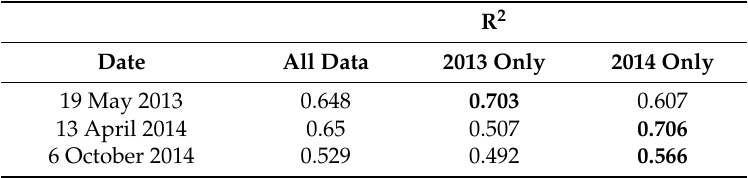
Table 5. Model coefficients and variance determined using a linear mixed-effects model, and the number of field plots used to calibrate each model.